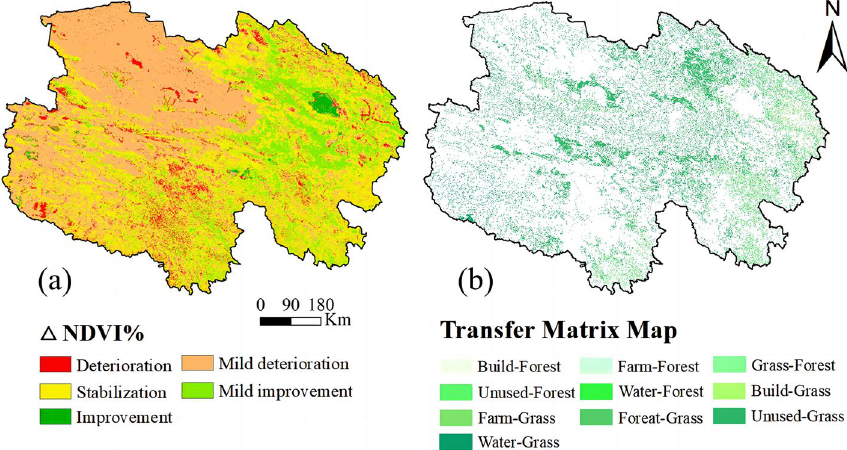
Figure 2. ( a ) Changes in the Normalized Difference Vegetation Index (NDVI) from 1995 to 2020; ( b ) Types of land-use transfer from 1995 to 2020 (made in ArcGIS 10.4.1, https:// www. esri. com/ zh- cn/ arcgis/ produ cts/ arcgis- deskt op/ resou